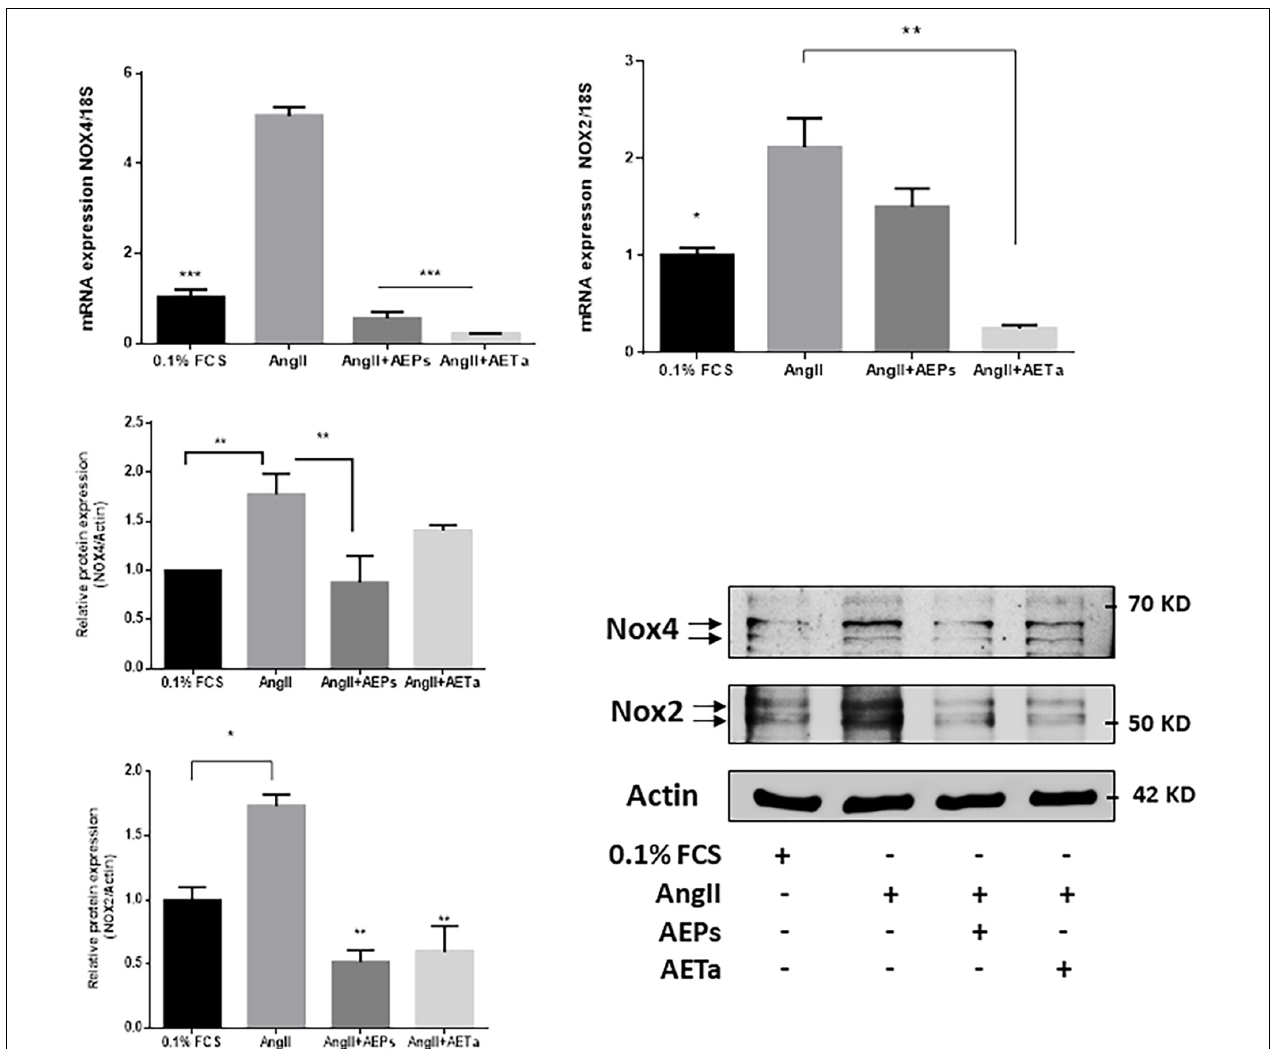
FIGURE 4 | Prosopis strombulifera and Tessaria absinthioides downregulate NOXs expression. Relative mRNA expression was calculated as 2 − (cid:49)(cid:49) Ct . Data are means ± SEM. * P ≤ 0.05, ** P ≤ 0.01; *** P ≤ 0.001 vs AngII. AEPs (Aqueous extract of Prosopis strombulifera ); AETa (Aqueous extract of Tessaria absinthioides ). Nox2 and Nox4 protein expression was examined in VSMC pretreated with AEPs or AETa and stimulated with AngII. Graph represents quantification of all data ( n = 3). * P ≤ 0.05; ** P ≤